Question: Sum up the contents of this chart in one sentence.
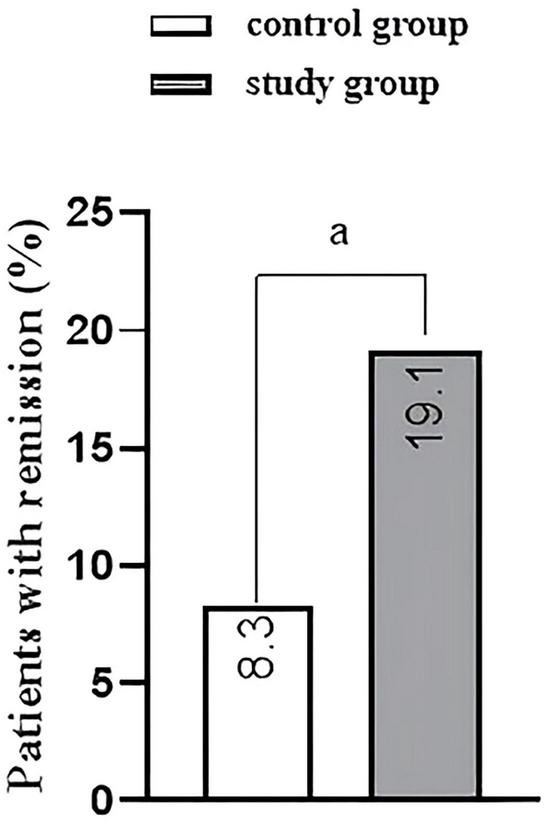
Answer: Comparison of clinical remission rate between the two groups at 12 weeks after treatment. a P < 0.05 vs. control group, RR = 2.30, 95% CI: 0.78–6.75.